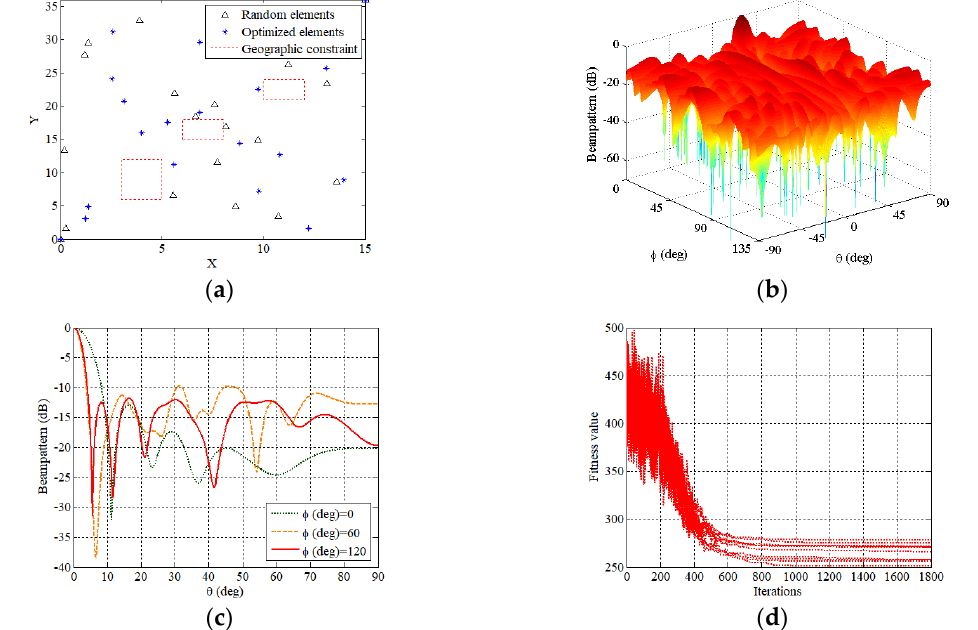
Figure 1. ( a ) The 21-element sparse planar arrays with random and optimized deployment that satisfy the minimum spacing and geographic constraints. ( b ) The beampattern of the optimized sparse planar array when the peak of the main-lobe is at (30°, 0°) . ( c ) The beampatterns in 𝜑 = 0° , 𝜑 = 60° , and 𝜑 = 120° planes. ( d ) The convergences of the fitness value versus the number of iterations through 10 trials.